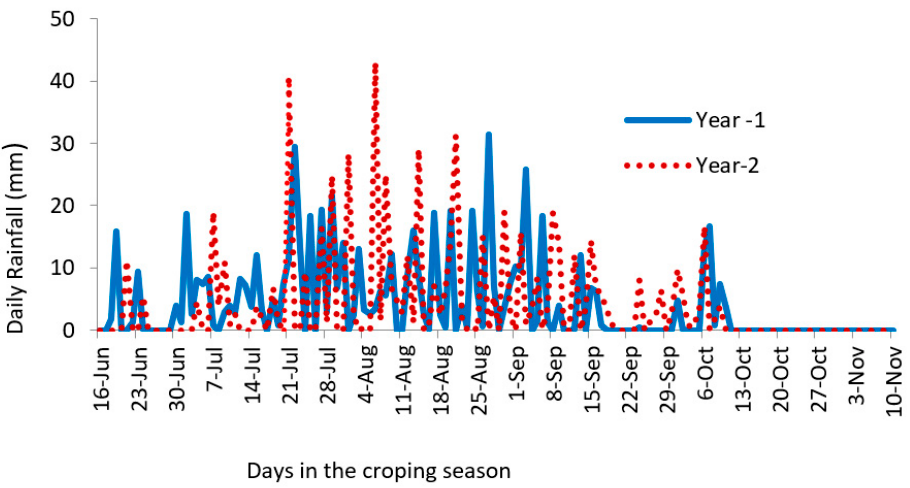
Figure 3. Daily precipitation at the experimental site during the 2013 and 2014 cropping seasons.